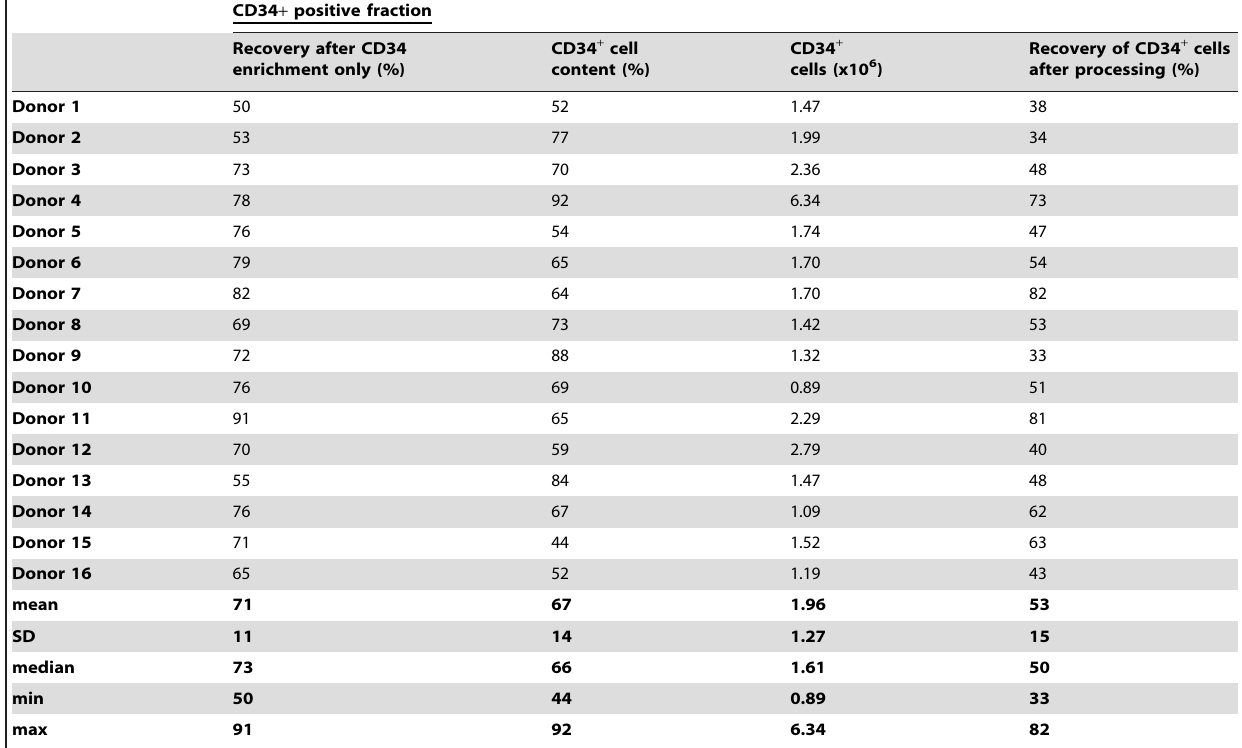
Table 2. Characteristics of the CD34 CliniMACS separation on thawed UCB